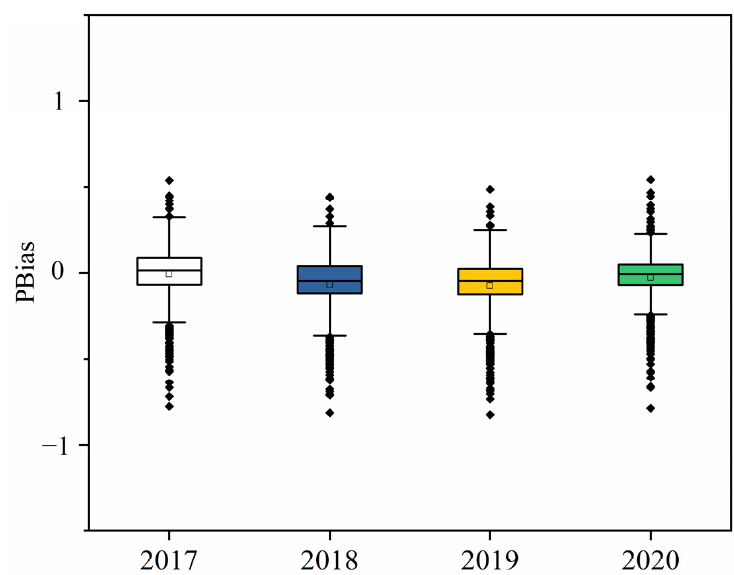
Figure 13. The box diagram of annual PBias of ET 0 calculated from CLDAS dataset.